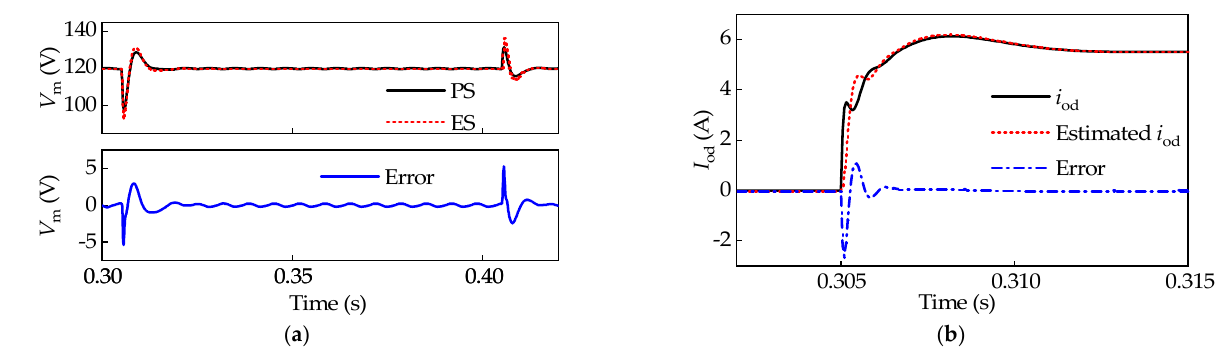
Figure 11. Simulation comparisons between PS and ES schemes under load switching. ( a ) Voltage amplitude; ( b ) D -axis load current and estimated value after adding load. Table 4. THD (%) values under different schemes in the simulation.